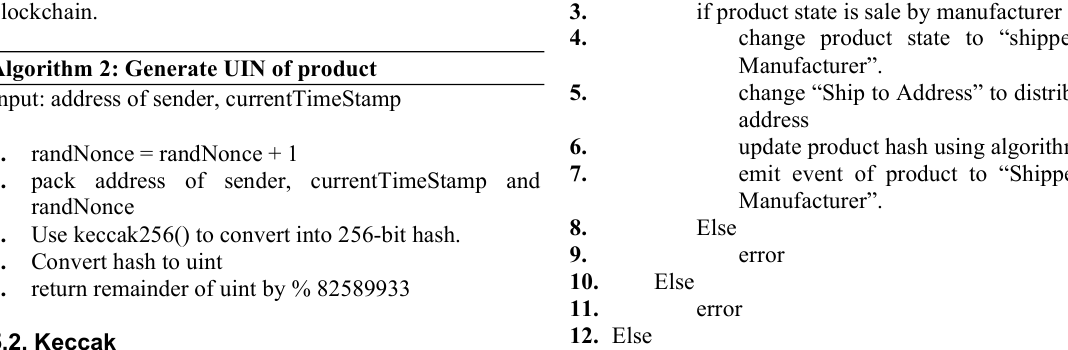
Algorithm 2: Generate UIN of product